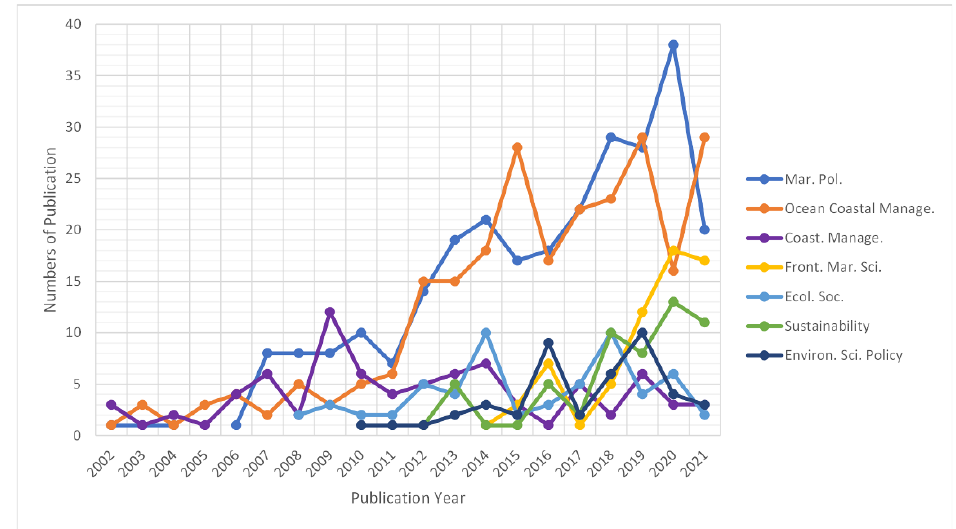
Figure 6. Journal publication trends (last 20 years). Table 4. Journals with the highest numbers of publications in the journal trends.